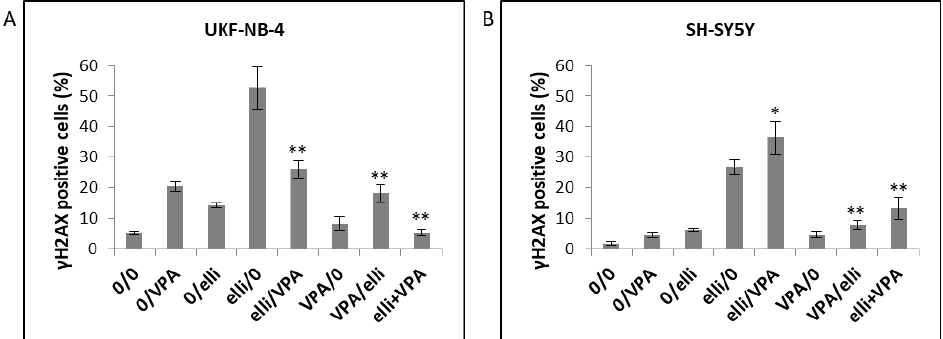
Figure 9. Analysis of phosphorylated H2AX in UKF-NB-4 ( A ) and SH-SY5Y ( B ) cells induced by 5 µM ellipticine (elli), 1 mM valproic acid (VPA) and their various combinations. Experimental treatment conditions are described in Table 1. Values represent mean ± SD from three independent experiments. * p < 0.05, ** p < 0.01 as compared to elli/0 group (ANOVA with post-hoc Tukey HSD Test).